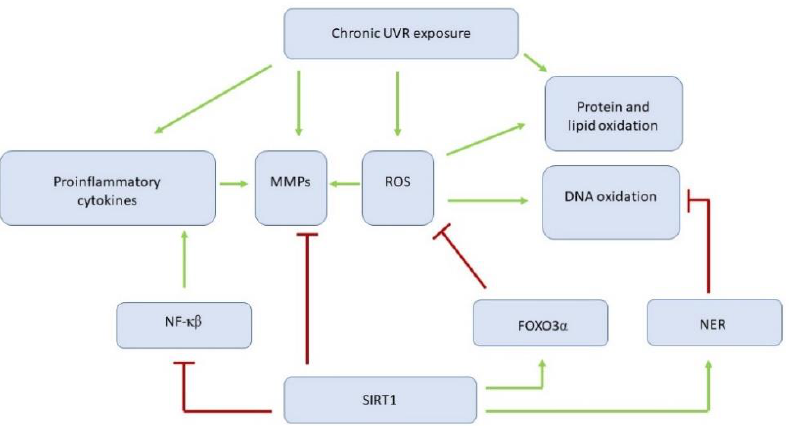
Figure 2. Multidirectional impact of ultraviolet radiation on skin aging. (UVR, ultraviolet radiation; MMPs, matrix metalloproteinases; ROS, reactive oxygen species; NF-k β , nuclear factor kappa-light- chain-enhancer of activated B cells; FOXO3 α , Forkhead Box O3 alpha; NER, nucleotide excision repair system; SIRT1, sirtuin